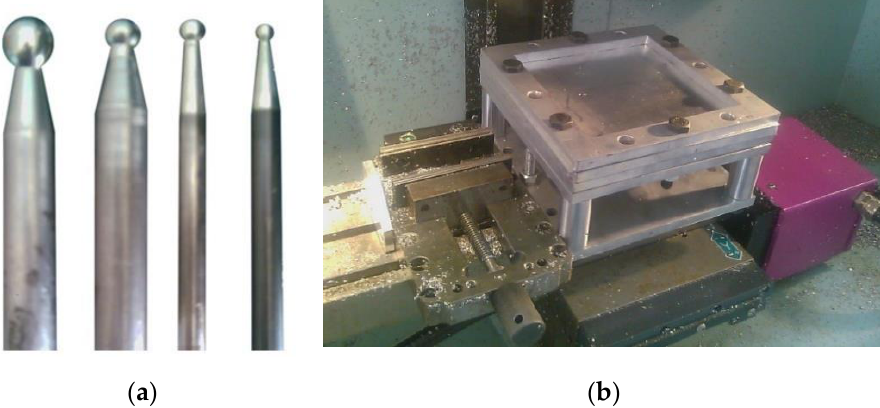
Figure 2. ( a ) Forming tools with different diameters, ( b ) fixture rig on the CNC machine table.